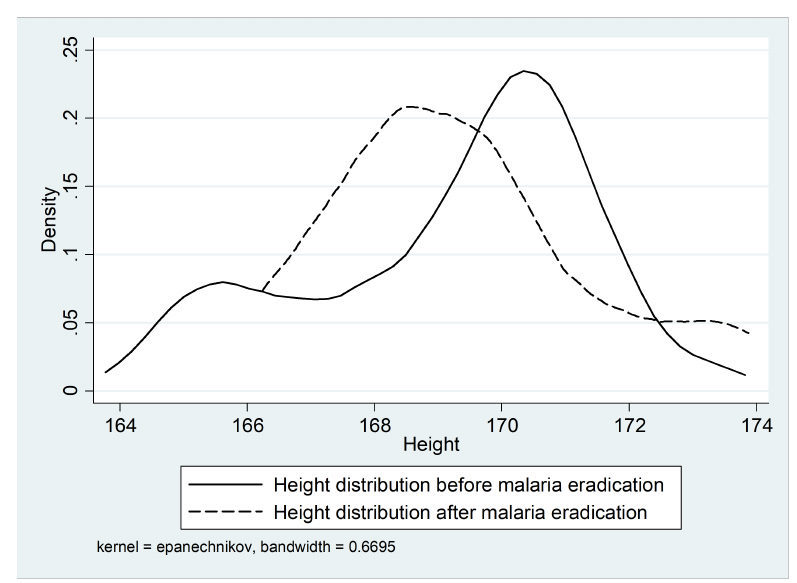
Figure 4: Change in height distribution in regions with low malaria mortality rates